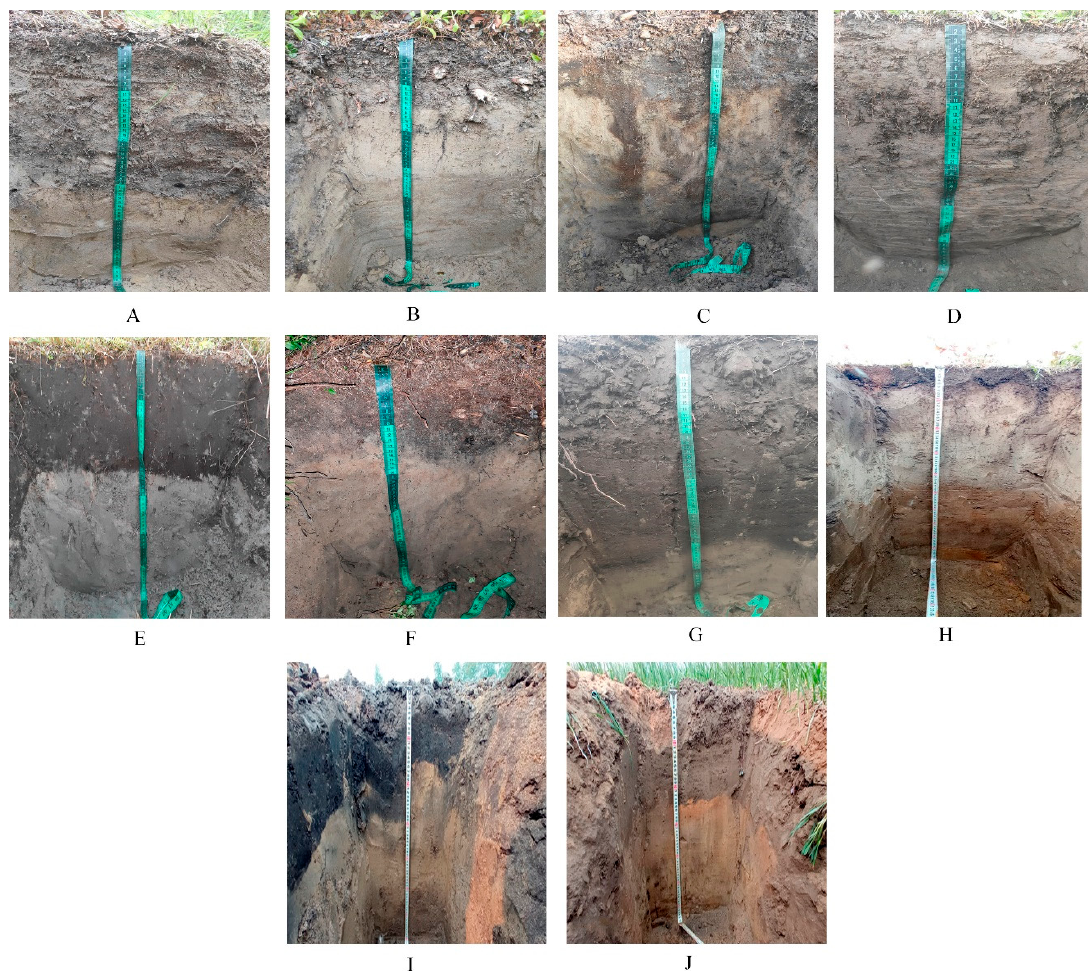
Figure 2. The studied fallow, arable and pyrogenic soils in the vicinity of Yakutsk. ( A ) Fallow soil